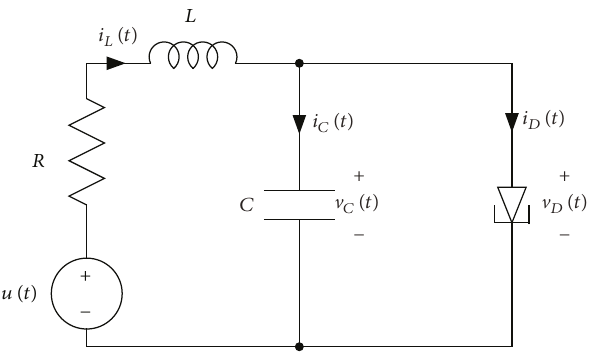
Figure 1: Tunnel-diode